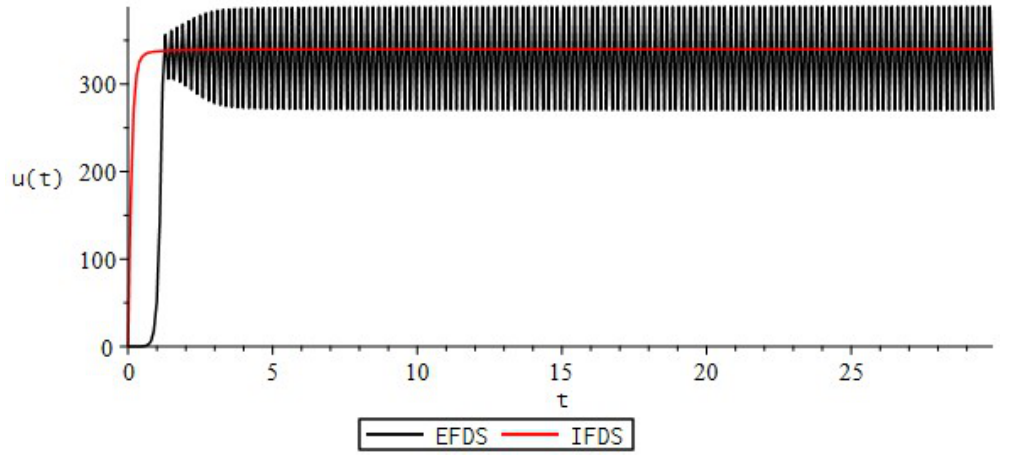
Figure 2. Numerical solutions of the fractional Riccati equation with constant coefficients and α = 0.9 when the condition is violated.